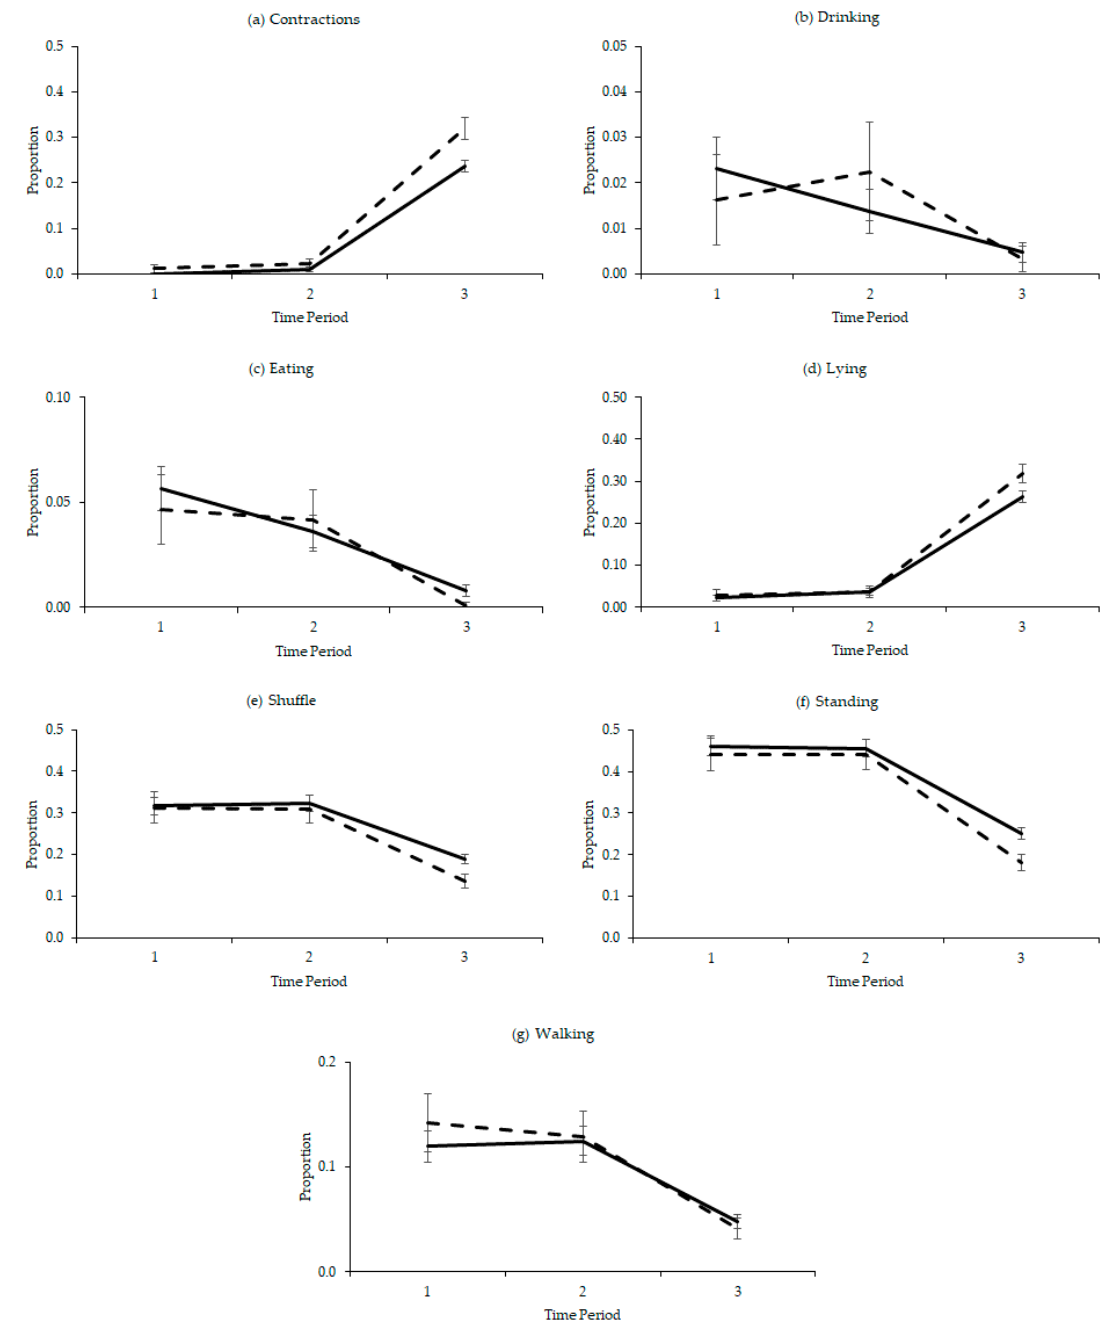
Figure 4. Predicted mean (± SEM) proportion of observations that were ( a ) contractions, ( b ) drinking, ( c ) eating, ( d ) lying, ( e ) shuffle, ( f ) standing and ( g ) walking behavior for assisted (dashed line) or unassisted (solid line) dairy cow calvings ( n = 35) in time periods one to three, with period three ending with the birth.